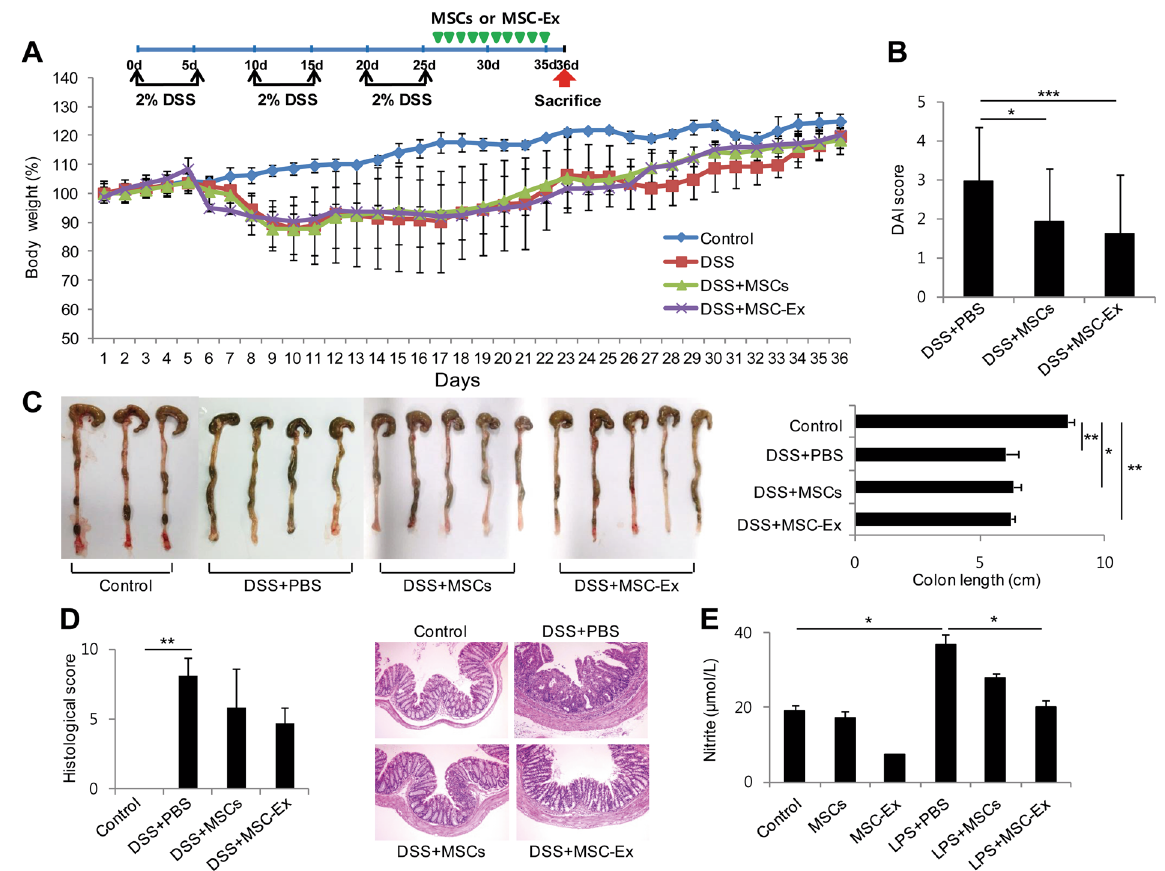
Figure 7. MSC-Ex is more efficient than MSCs in the chronic colitis model. (A) The schematic protocol for chronic DSS-induced mouse colitis and intraperitoneal injection of MSC-Ex as described in Fig. 1A. ( B ) DAI was determined as described in Fig. 1B. ( C ) Colon length. (D) Histological scores were calculated as described in Fig. 1E. Representative H&E stained sections are shown. (E) The levels of nitrite, a final metabolite of NOS, were measured using the culture media from the basolateral side in the co-culture system of Caco-2 and RAW 264.7 cells. Data are represented as the means ± s.d. ( n ≥ 5 mice per group). * P < 0.05, ** P < 0.005, *** P < 0.001